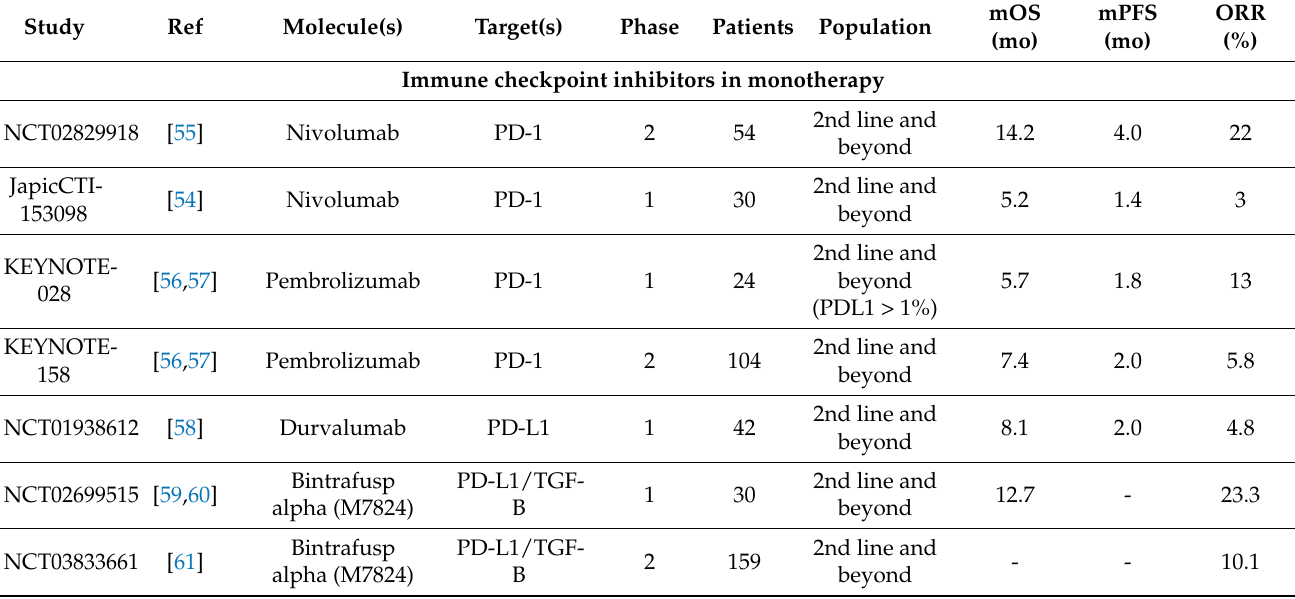
Table 1. Selected published trials with immunotherapies in advanced biliary tract cancer.